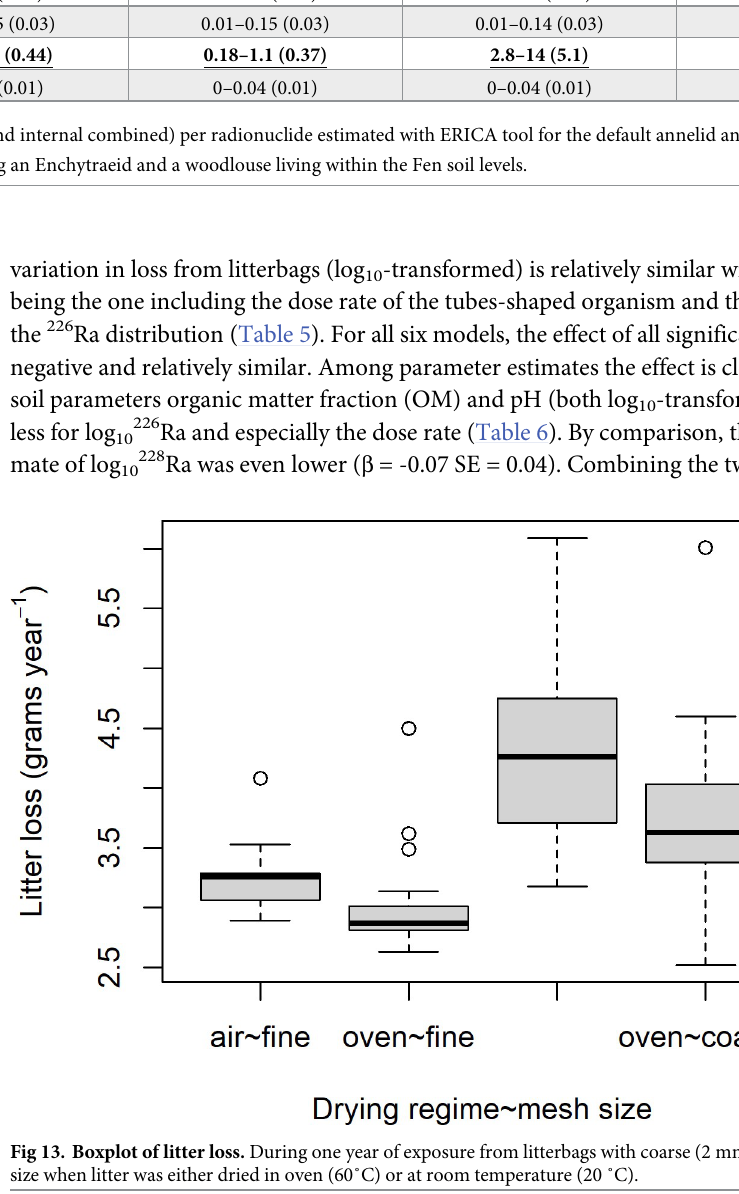
Fig 13. Boxplot of litter loss. During one year of exposure from litterbags with coarse (2 mm) and fine (0.1 mm) mesh size when litter was either dried in oven (60˚C) or at room temperature (20 ˚C).